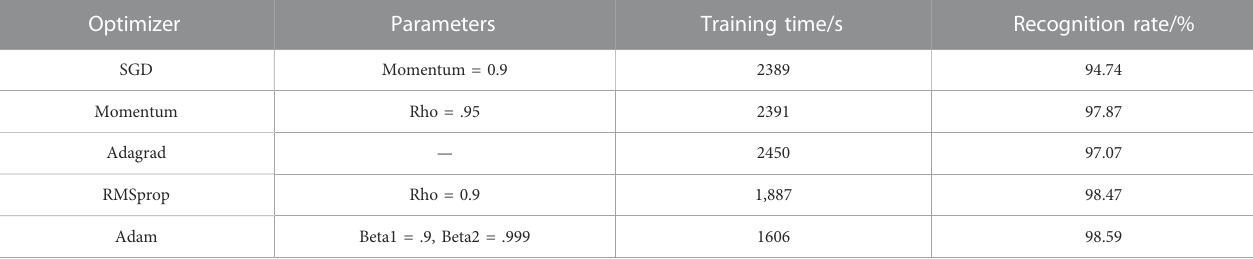
TABLE 4 Experimental results of different